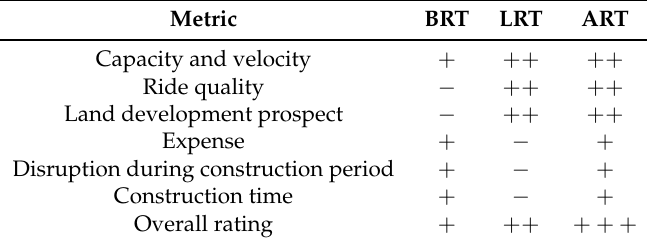
Table 1. Comparisons of bus rapid transit (BRT), light rail transit (LRT), and Autonomous rail transit (ART)